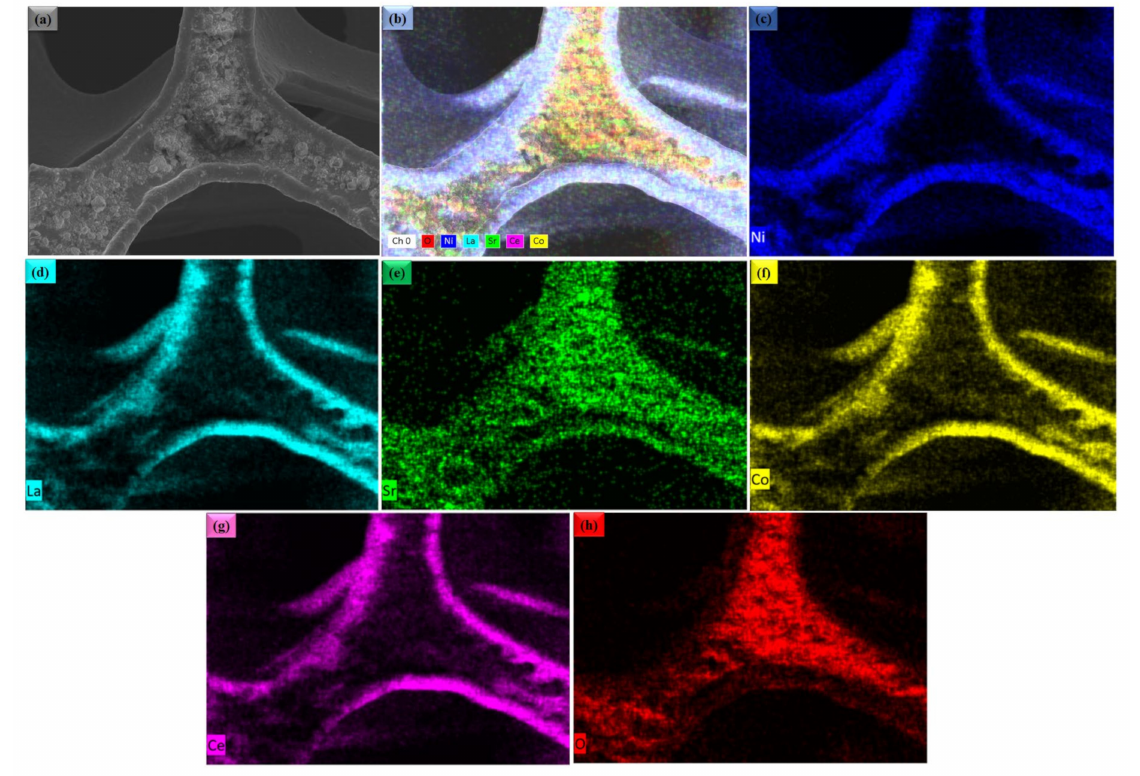
Figure 3. ( a ) The surface morphology studied by SEM for La 0.2 Sr 0.8 Co 0.8 Ce 0.2 O 3 − δ embedded on porous Ni-foam substrate; ( b – h ) combined and individual EDS mapping image of Ni, La, Sr, Co, Ce